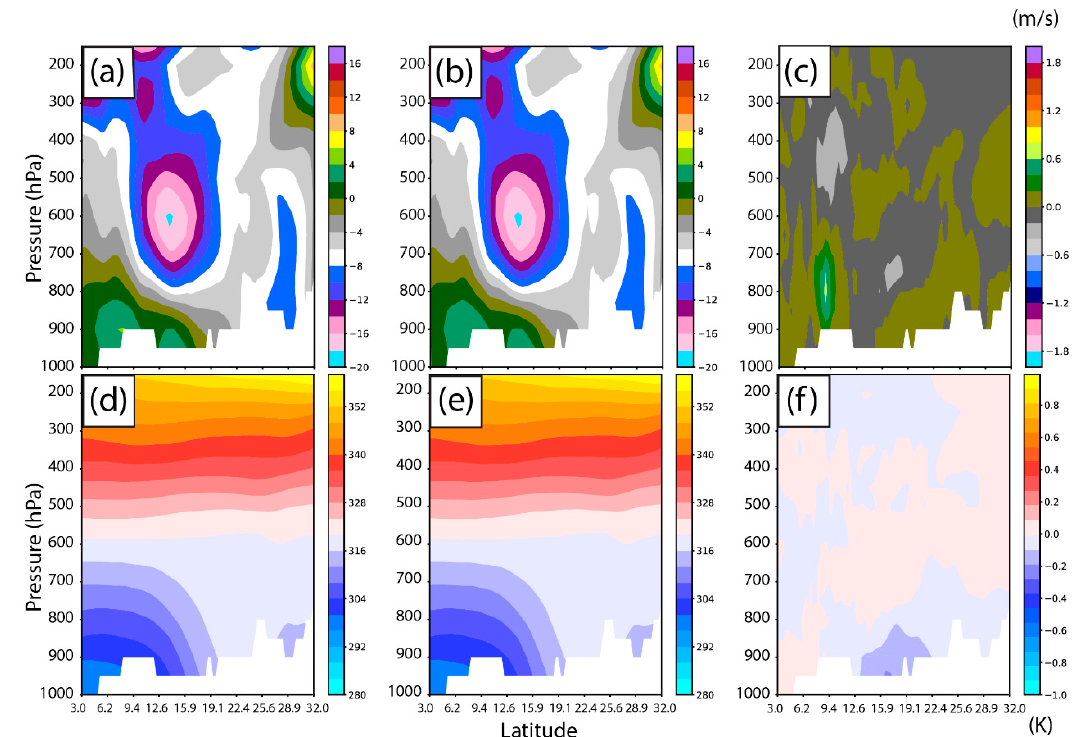
Figure 11. Averaged (from 1300 UTC 21 to 0000 UTC 23) vertical meridional cross-sections of zonal wind (15° W to 10° E, m/s) from ( a ) ExDO, ( b ) ExO, and ( c ) the difference (ExDO − ExO). Cross-sections ( d – f ) are similar to ( a , c ) but are for the temperature (K).